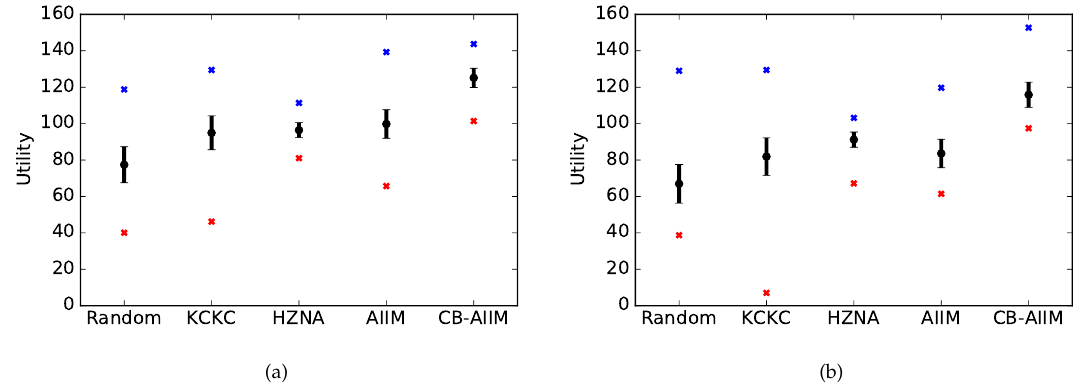
Figure 6. ( a , b ) Results for two different settings with low classroom occupancy (12 classrooms under use).